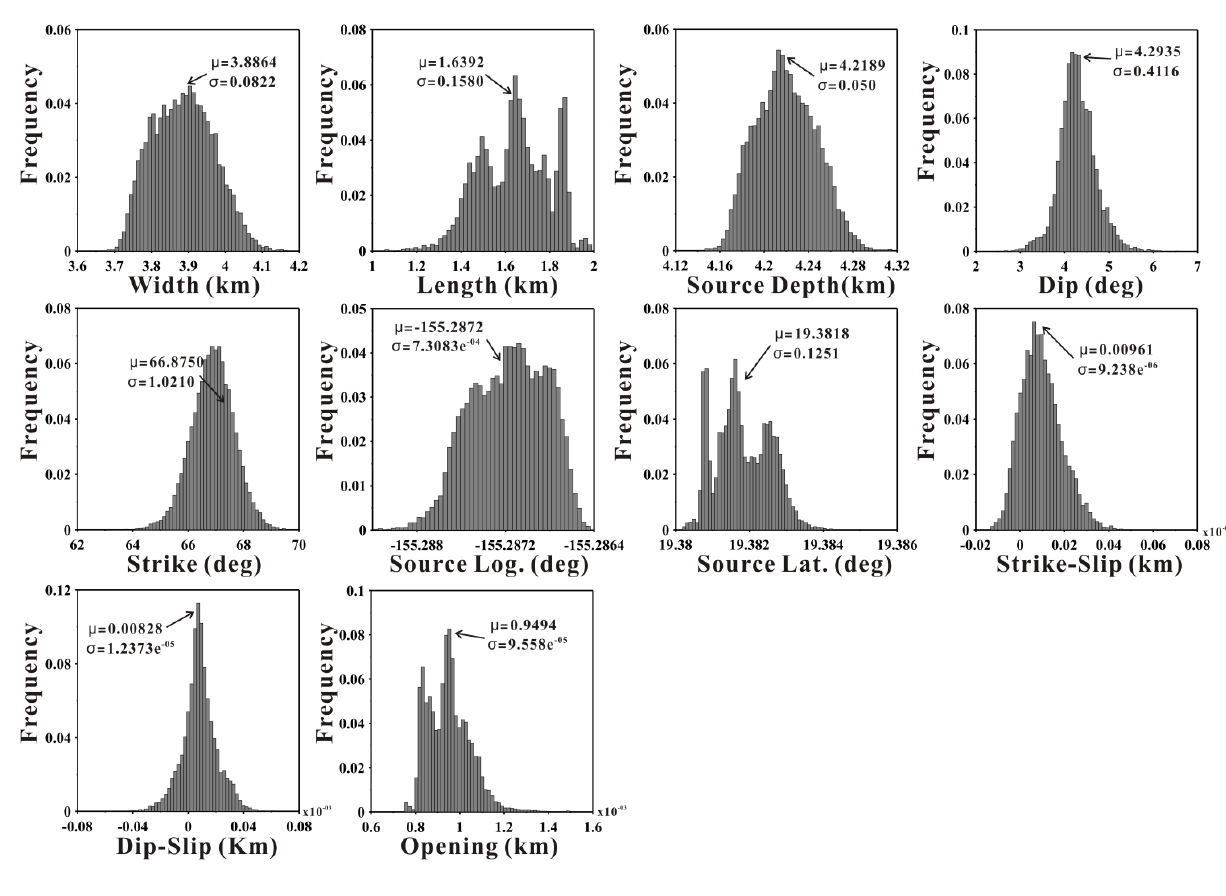
Figure 6. Histograms of the magma source parameters estimated from the 3D measurement inputs using the Okada dislocation